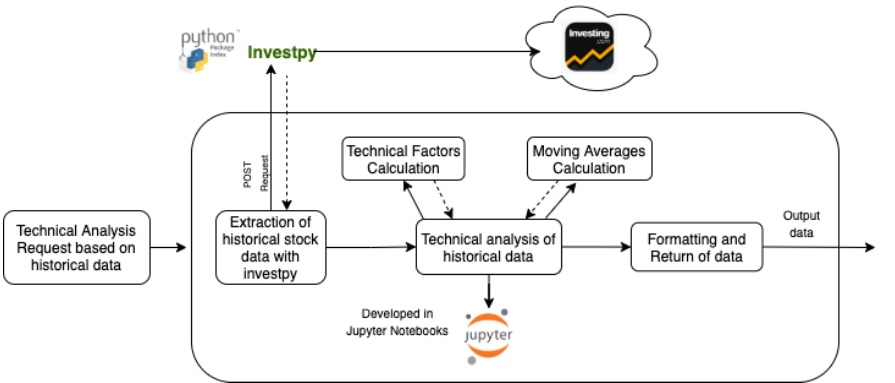
Figure 7. Technical Analysis Package Design